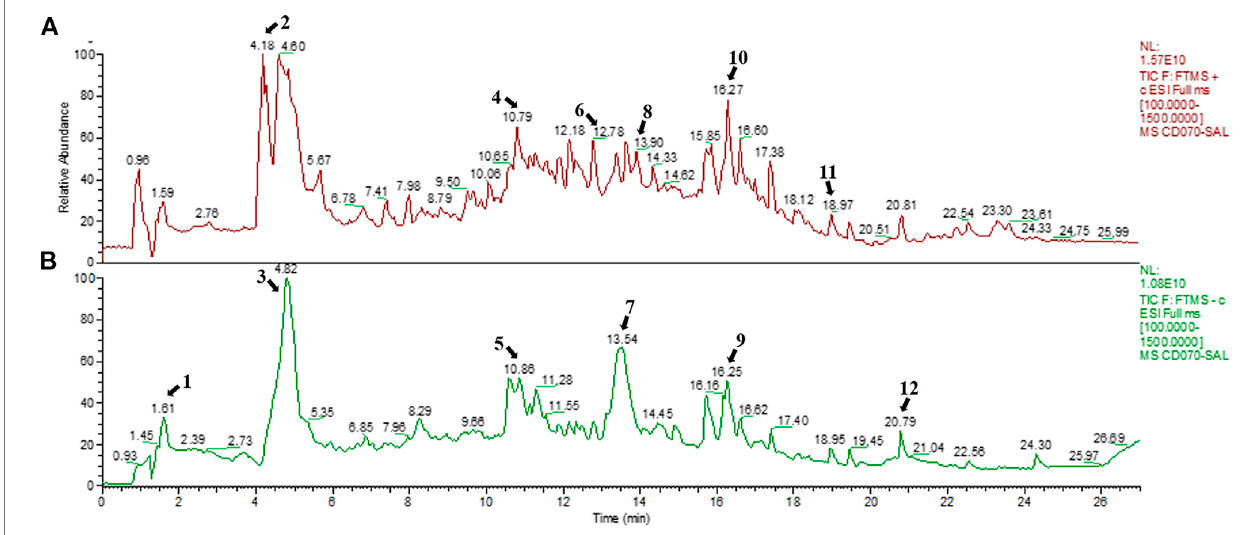
FIGURE 1 | Chemical composition of SAL. (A) Positive mode; (B) negative mode.